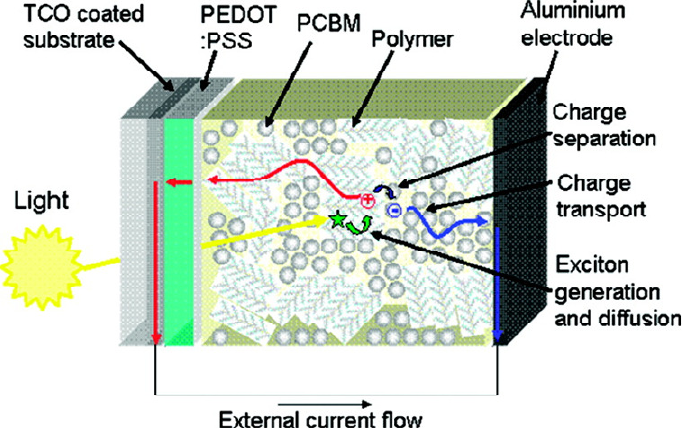
Figure 10. Schematic depiction of the photovoltaic operation for a bulk heterojunction solar cell. (Reprinted with permission from Reference [107]. Copyright (2008) by Materials Research